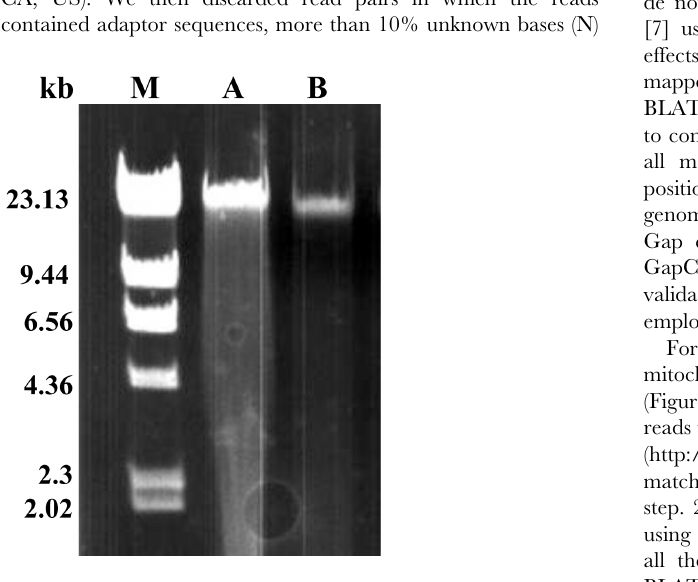
Figure 3. Comparison of DNA extracted with CTAB versus PCE. A) Total DNA extracted with CTAB and B) extracted with PCE; M denotes Lambda DNA/Hind III.